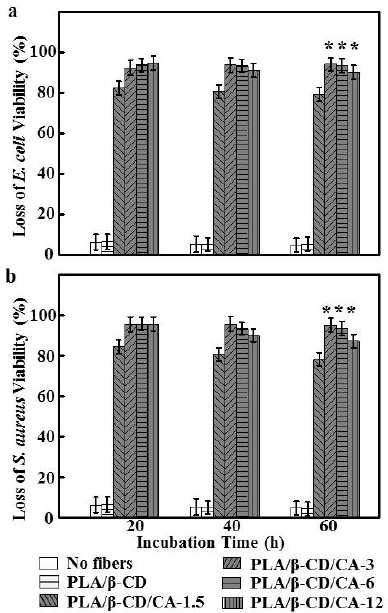
Figure 4. Antibacterial activity. The cumulative release pro fi les of CA from different fi bers; n = 6.